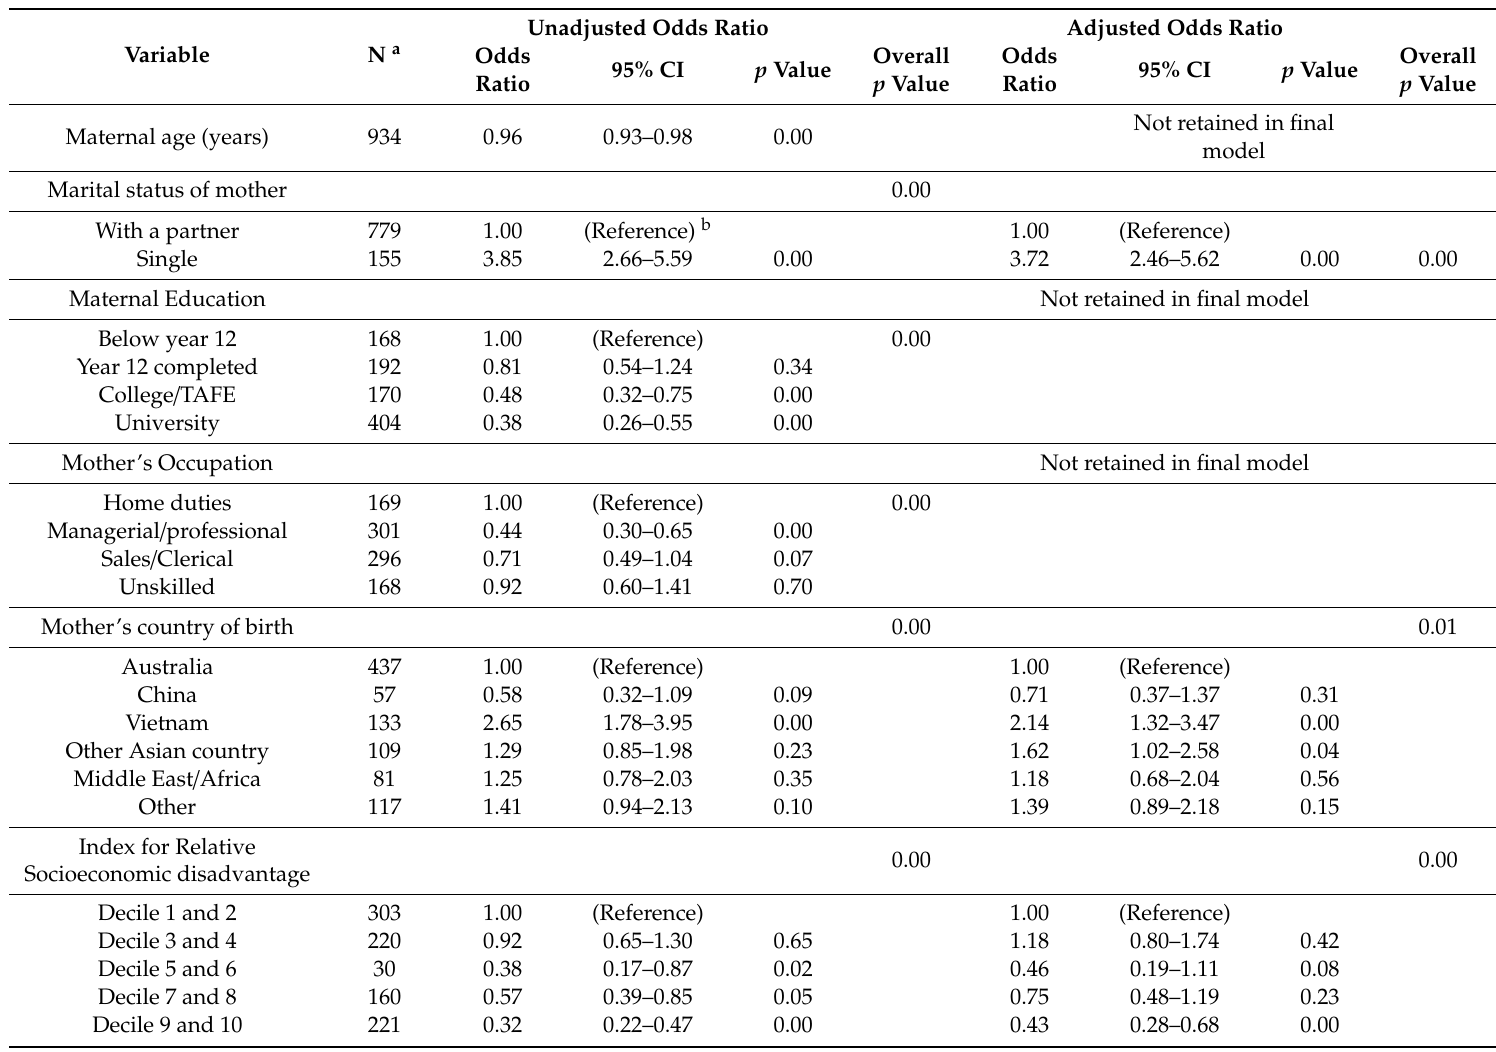
Table 2. Unadjusted and adjusted odds ratio for early introduction of SSBs ( < 52